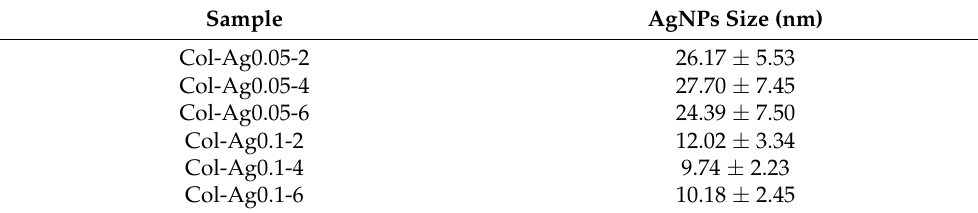
Table 1. Size of AgNPs formed in situ, inside the 3D-printed collagen-based